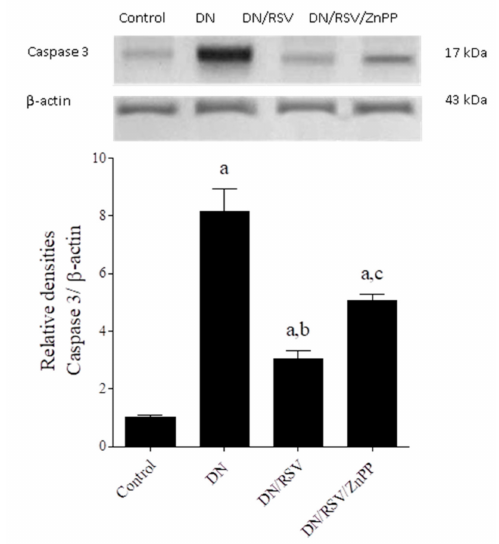
Figure 4. Effect of rosuvastatin (RSV) on renal Western blot analysis of caspase 3 expression in diabetic nephropathy (DN) in rats. ZnPP, zinc protoporphyrin-IX. Representative Western blot ( upper panel ) showing caspase 3 immune reactive protein and β -actin bands. Graph shows relative densitometry of caspase 3/ β -actin ratio ( lower panel ). Values are a representation of three blots as ratio means ± S.E.M. Results are considered significantly different when p < 0.05. a Significant difference compared to control, b significant difference compared to DN group, c significant difference compared to DN/RSV